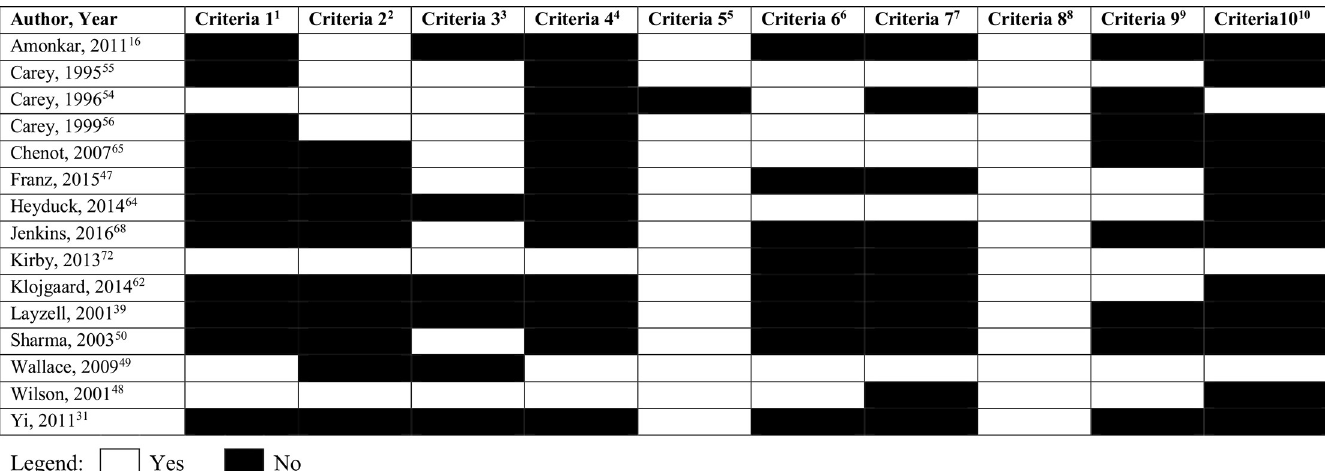
Fig 3. Hoy et al’s Risk of Bias tool for quantitative studies. 1 Criteria 1:Was the study’s target population a close representation of the national population in relation to relevant variables? 2 Criteria 2: Was the sampling frame a true or close representation of the target population? 3 Criteria 3: Was some form of random selection used to select the sample OR was a census taken? 4 Criteria 4: Was the likelihood of nonresponse bias minimal? 5 Criteria 5: Were data collected directly from the subjects? 6 Criteria 6: Was an acceptable case definition used in the study? 7 Criteria 7: Was the study instrument that measured the parameter of interest shown to have validity and reliability? 8 Criteria 8: Was the same mode of data collection used for all subjects? 9 Criteria 9: Was the length of the shortest prevalence period for the parameter of interest appropriate? 10 Criteria 10: Were the numerator(s) and denominator(s) for the parameter of interest appropriate.